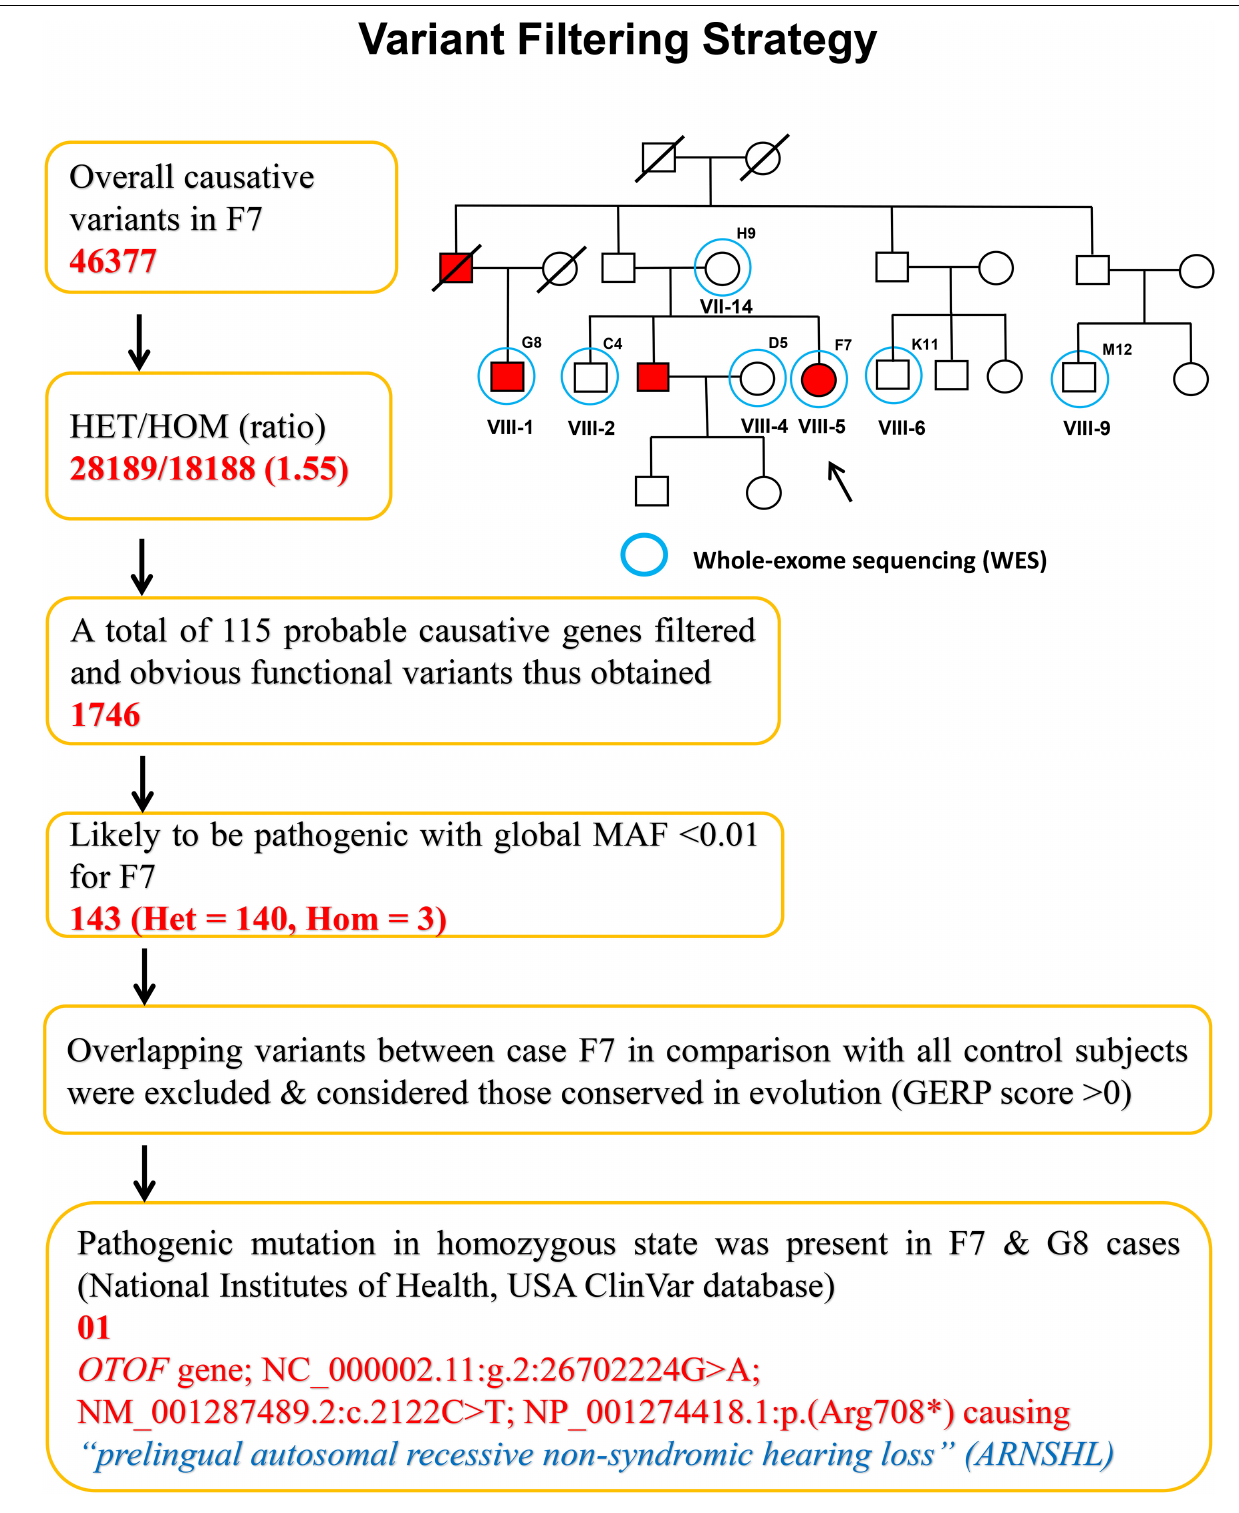
Frontiers in Genetics |